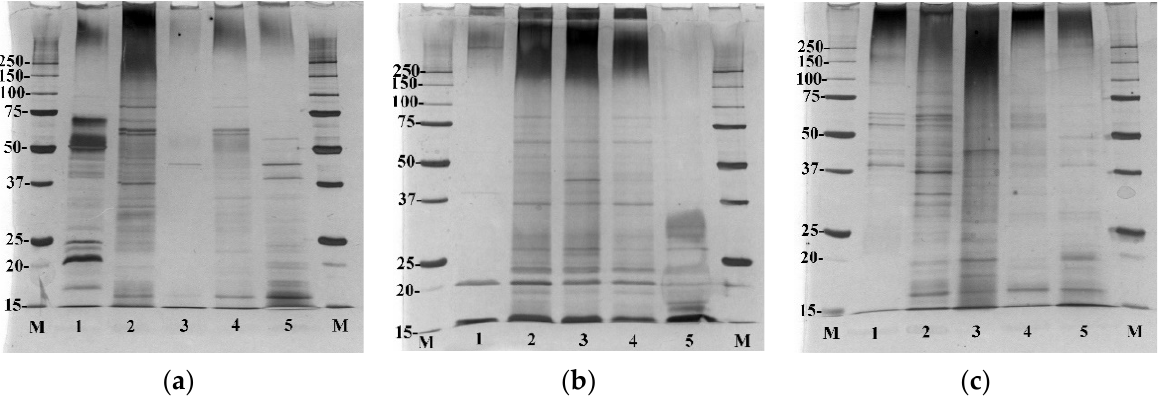
Figure 3. SDS-PAGE of EVs (1), whole-cell lysate (2), surface proteins (3), cytosolic proteins (4), cell wall proteins (5). ( a ) C. acnes DSM 1897 type IA1, ( b ) C. acnes DSM 16379 type IB, ( c ) C. acnes PCM 2334 type II. Silver staining.